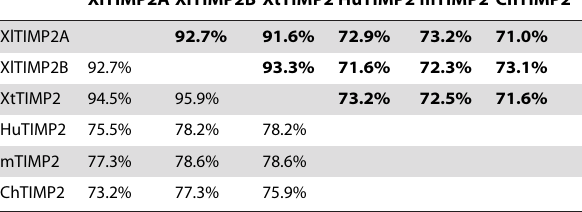
Table 2. Homology of X. laevis TIMP2 with the ortholog of other